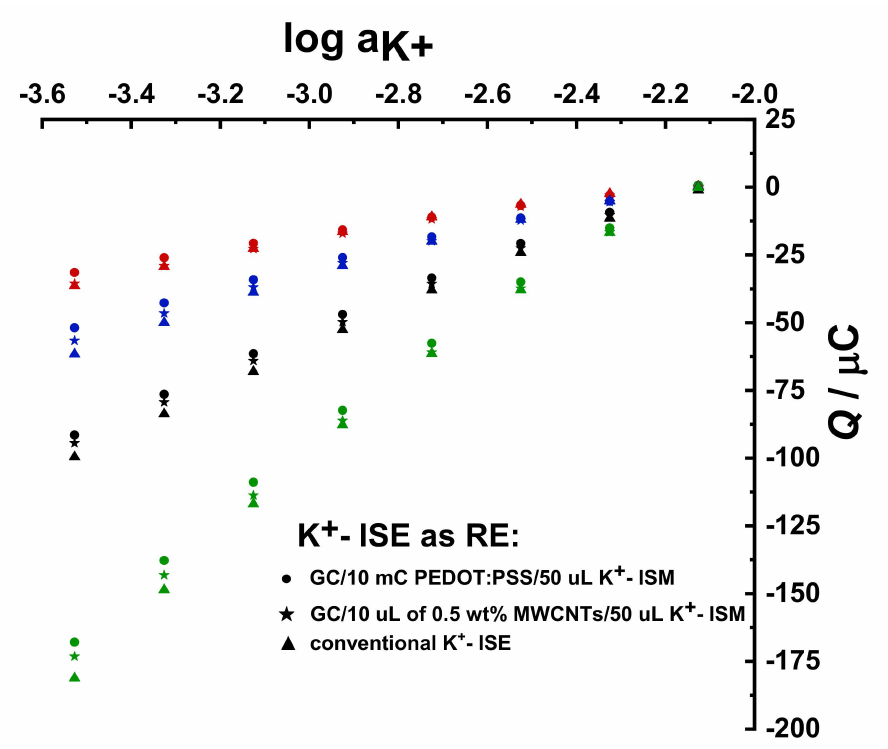
Figure 8. Cumulated charge Q vs. log a K+ from the calibration conducted in 10 − 2 M to 10 − 3.4 M KCl + 10 − 1 M NaCl as BGE with ∆ log C K+ = 0.2 decade step − 1 ; 3 mm GC/10 mC PEDOT:PSS/DM (red), 3 mm GC/20 mC PEDOT:PSS/DM (blue), 5 mm GC/27.8 mC PEDOT:PSS/DM (black), and 5 mm GC/55.5 mC PEDOT:PSS/DM (green) with equivalent dummy membrane thickness were used as WEs. Different K + - ISEs were used as REs, as indicated in the figure.